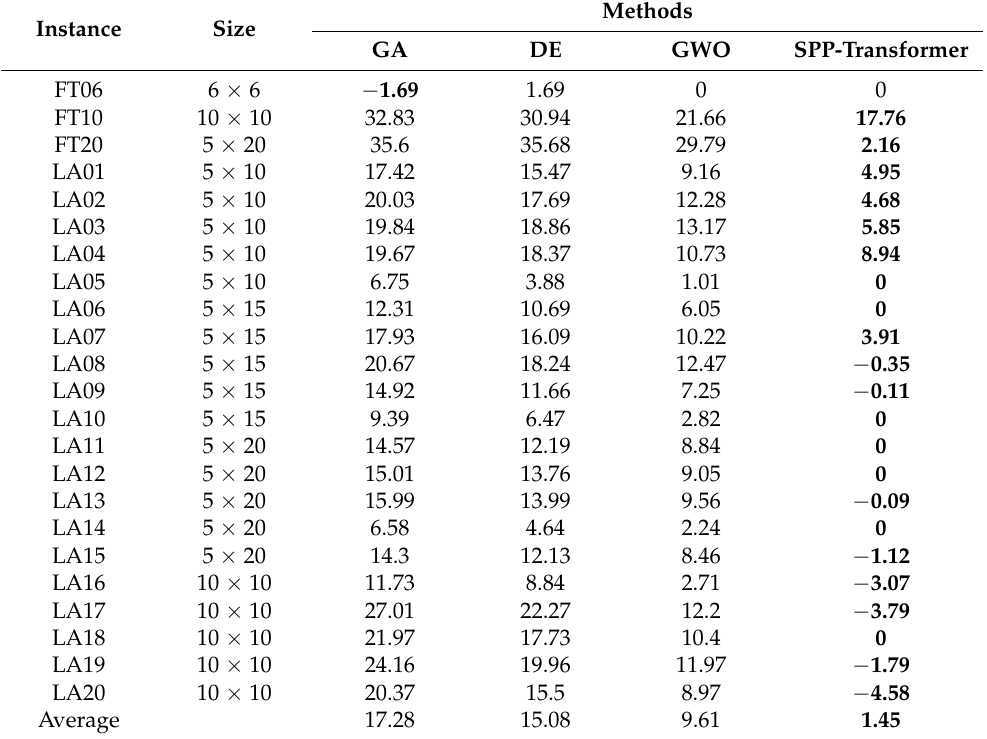
Table A6. The comparison between meta-heuristic methods and SPP-Transformer on RPD (%).